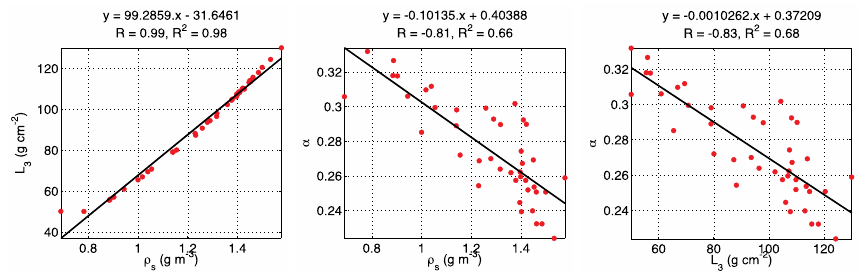
Fig. 6. Correlation of the site-specific optimized values of (a) L 3 and (b) α with the site-specific value of ρ s , and (c) correlation between the site-specific optimized values of α and L 3 .